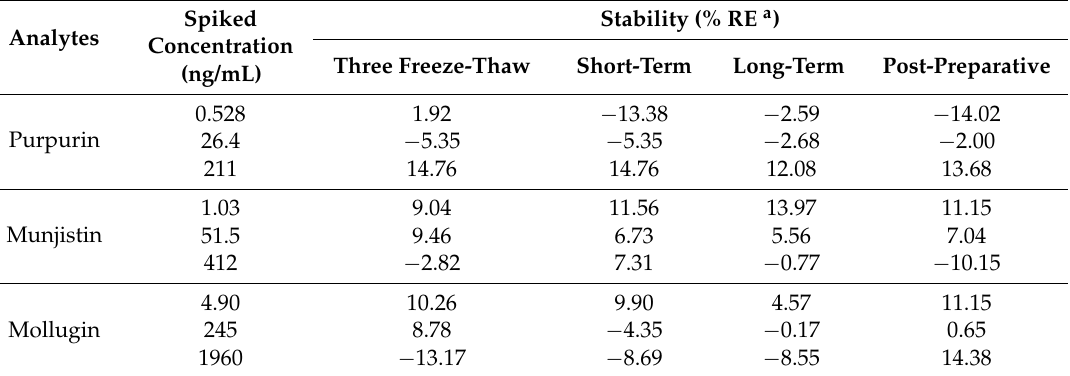
Table 5. Stabilities of the analytes in rat plasma ( n = 6).